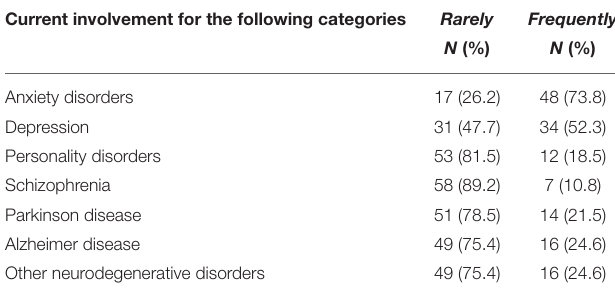
TABLE 6 | Categories of factors that represent barriers to getting involved in the management of mental health problems of the elderly population. Categories of factor that represent barriers to mental health care